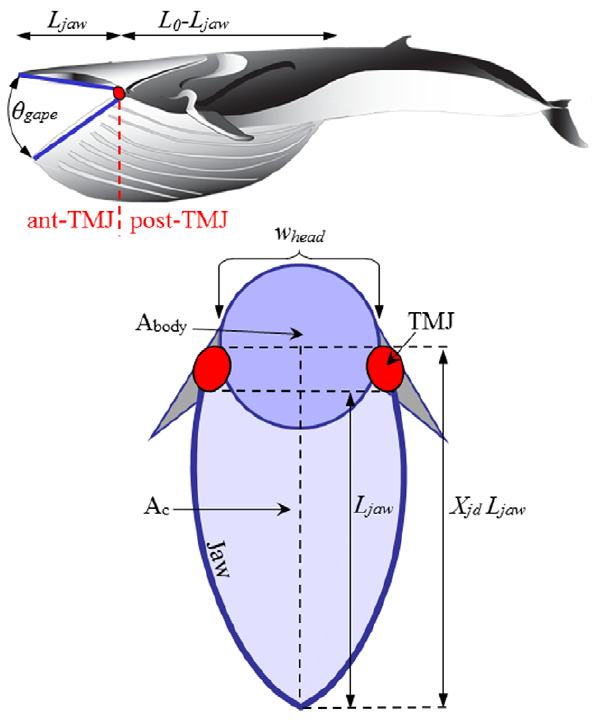
Figure 1. Dimensional characteristics of the mouth apparatus and ventral